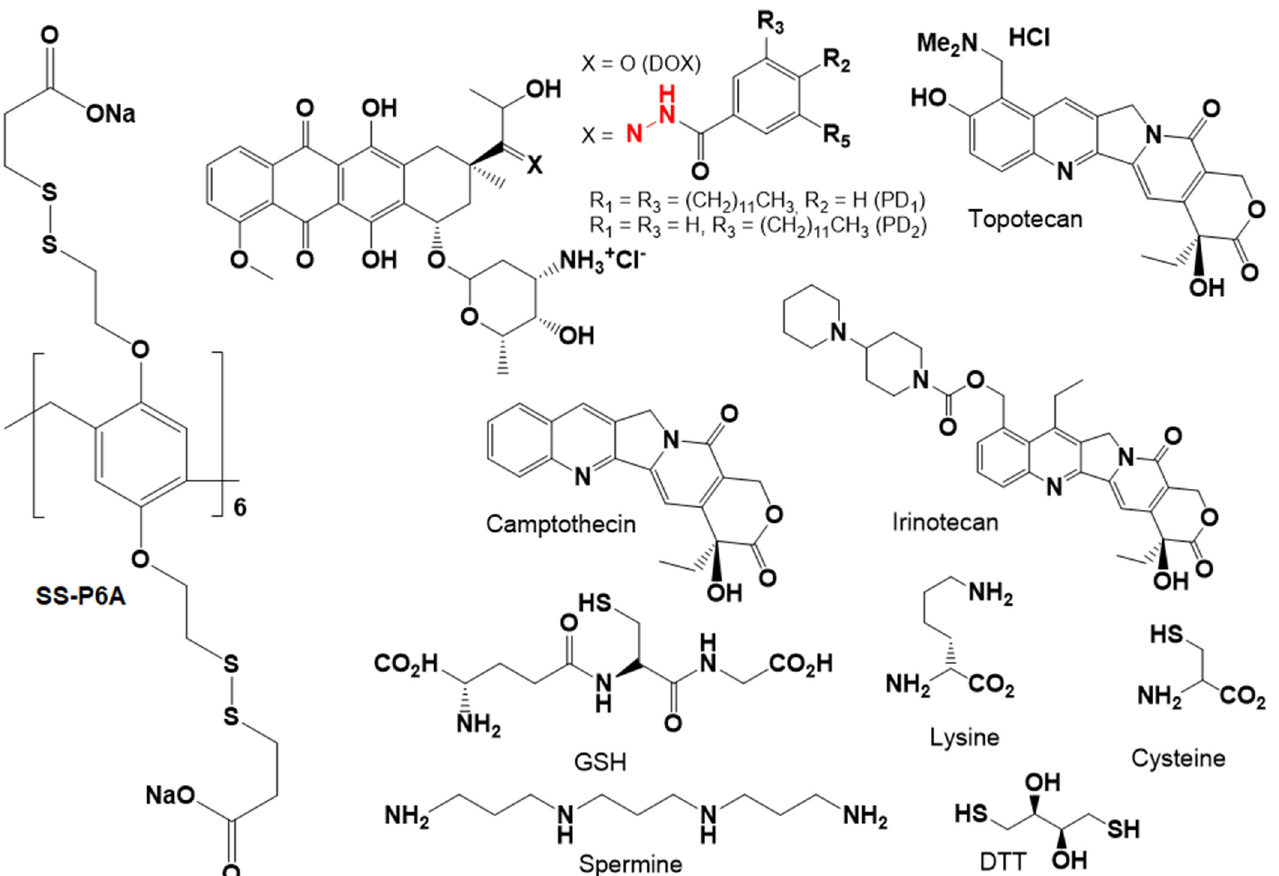
Figure 8. Chemical structures of host SS-P6A , anti-tumor drugs and prodrugs, thiols, and spermine.